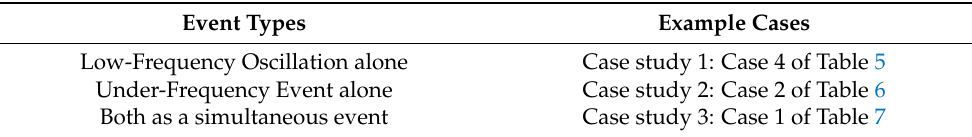
Table 8. Example cases for various types of frequency events verified in the OPAL RT real-time simulation